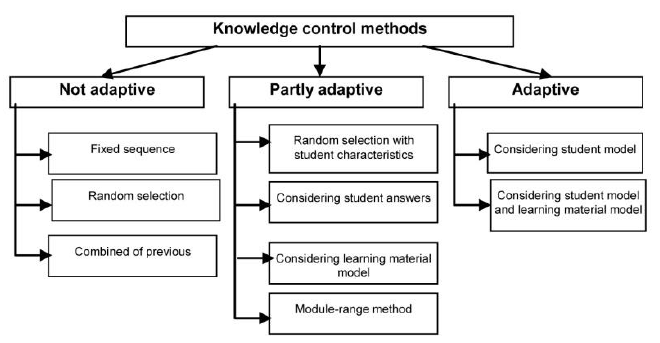
Fig. 1. Knowledge control